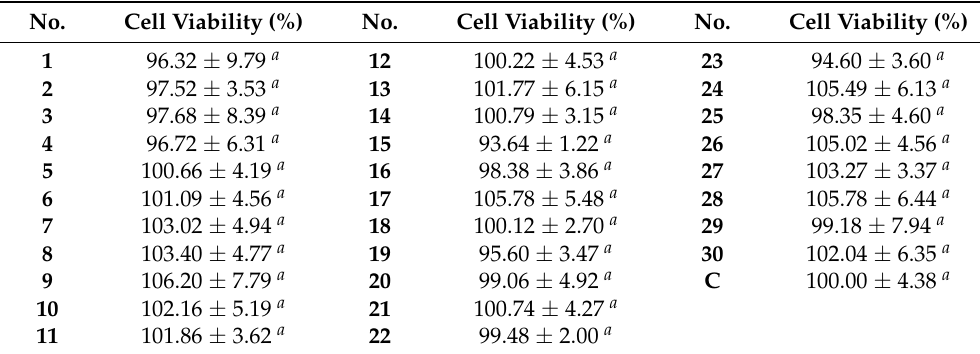
Table 2. The cell viability of 30 flavonoids in Caco-2